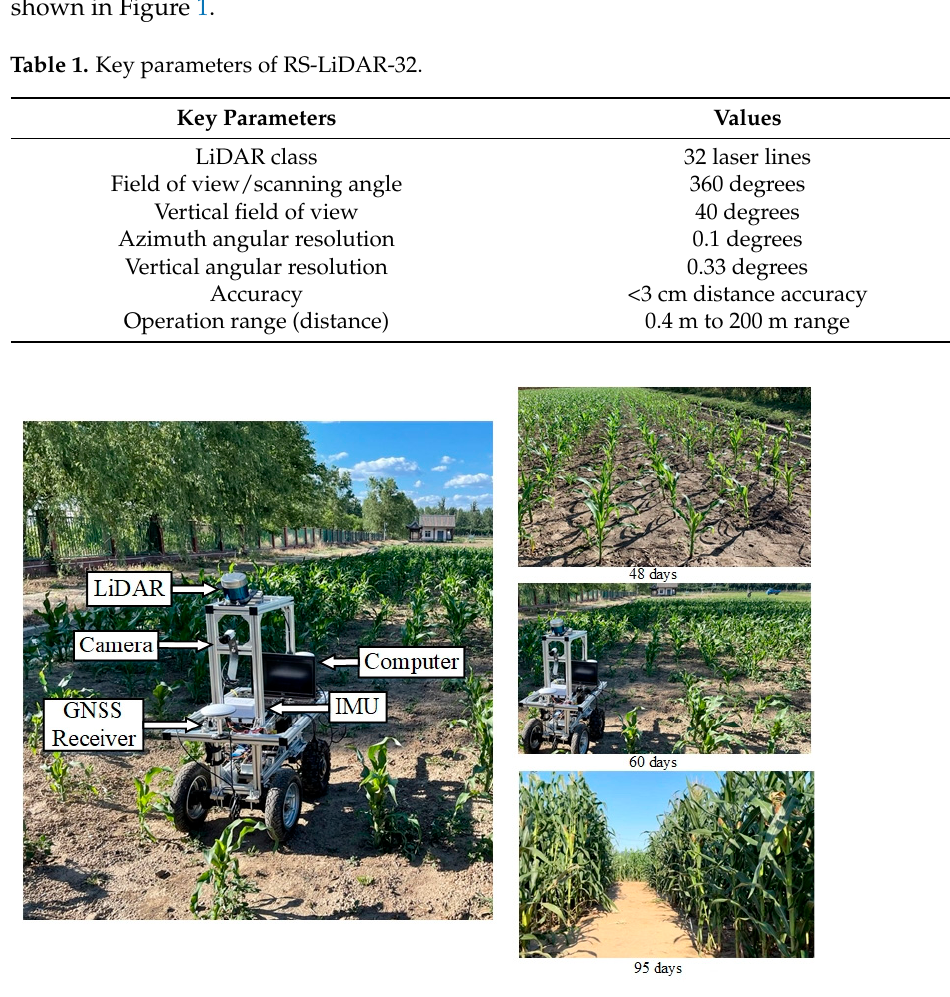
Figure 1. Mobile robot platform and test field.